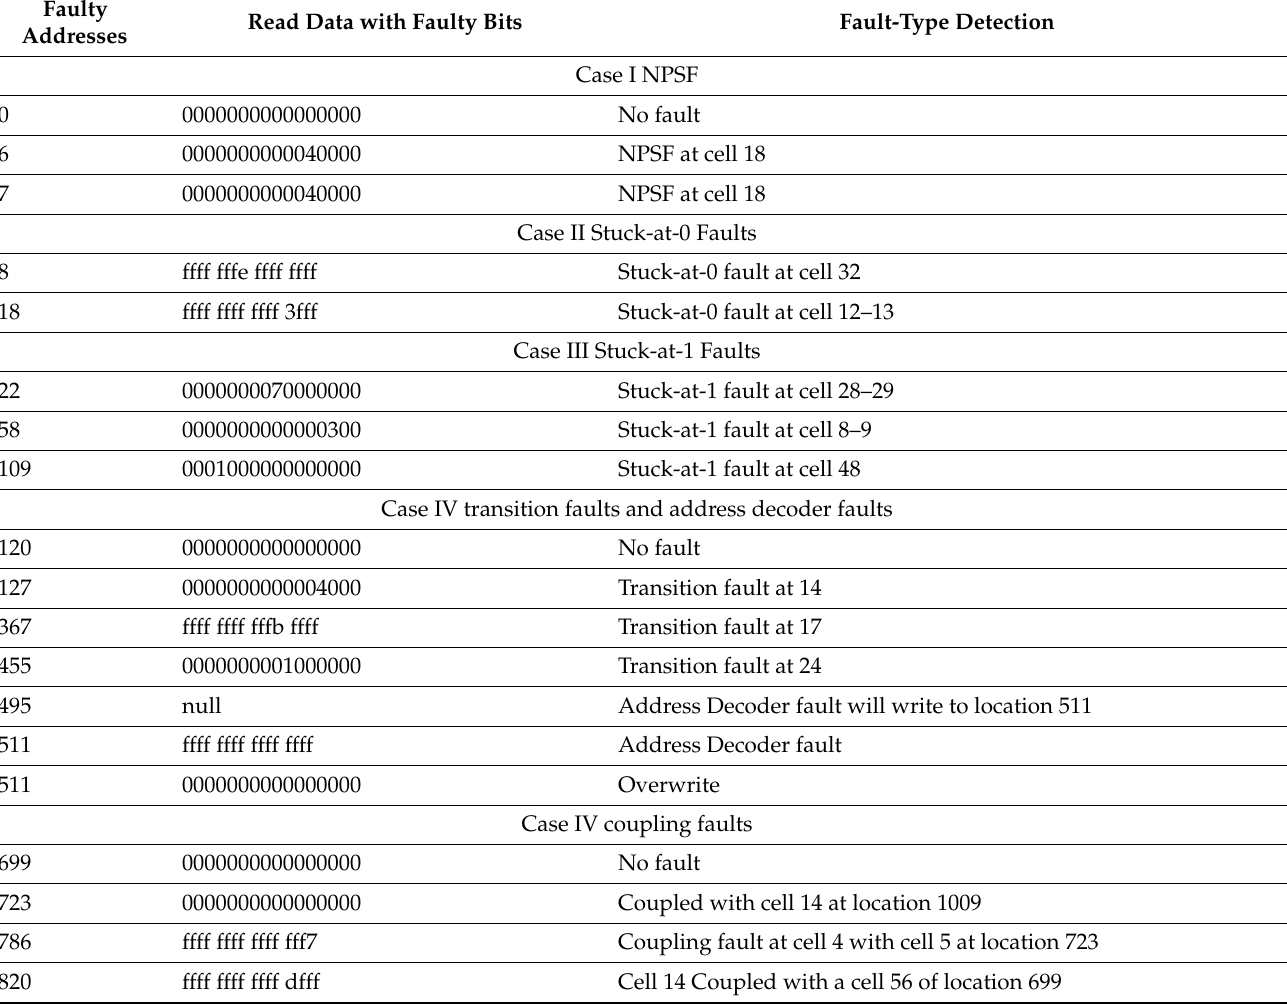
Table 2. Faults and their type detection from memory under